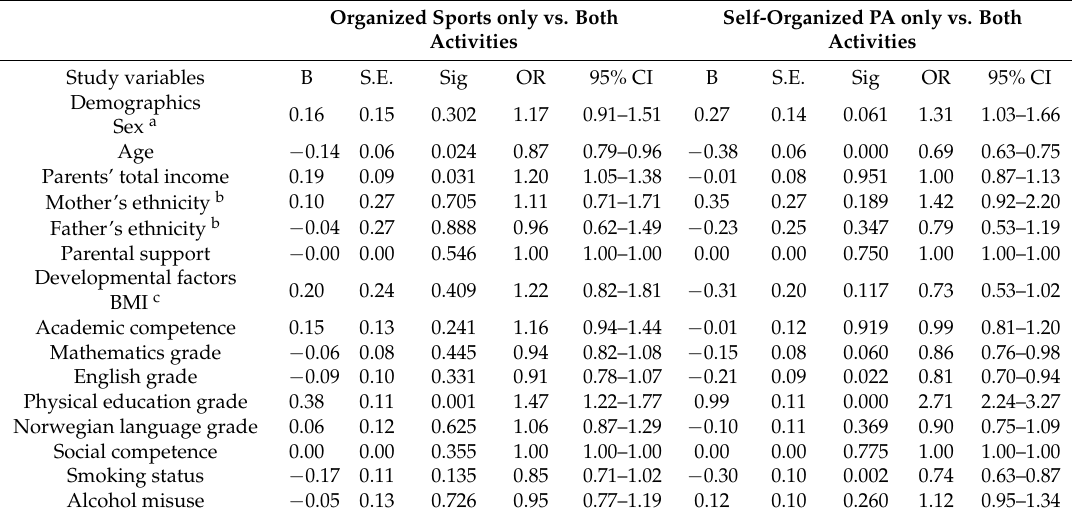
Table 4. Multiple logistic regression analyses: both organized sports and self-organized PA versus organized sports only or self-organized PA only. Organized Sports only vs. Both Self-Organized PA only vs. Both Activities